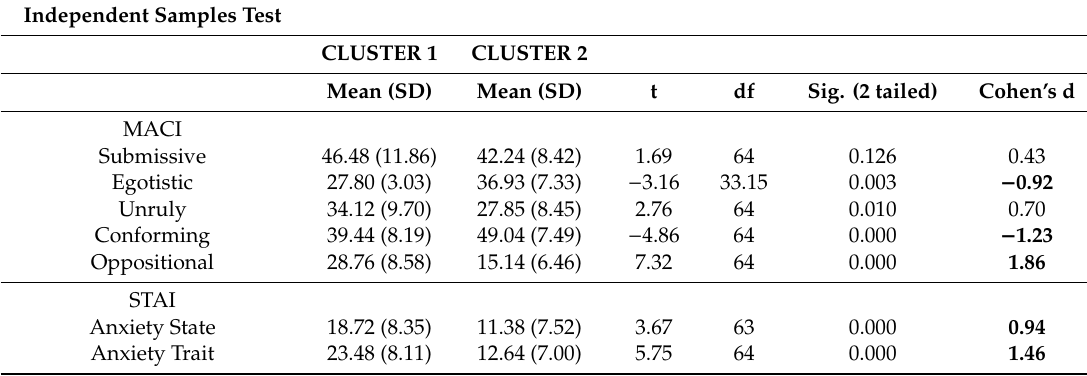
Table 2. T-test comparison between clusters of the personality traits of the MACI and the State-Trait Anxiety Index (STAI) scales (cluster 1 n = 24, cluster 2 n = 42).